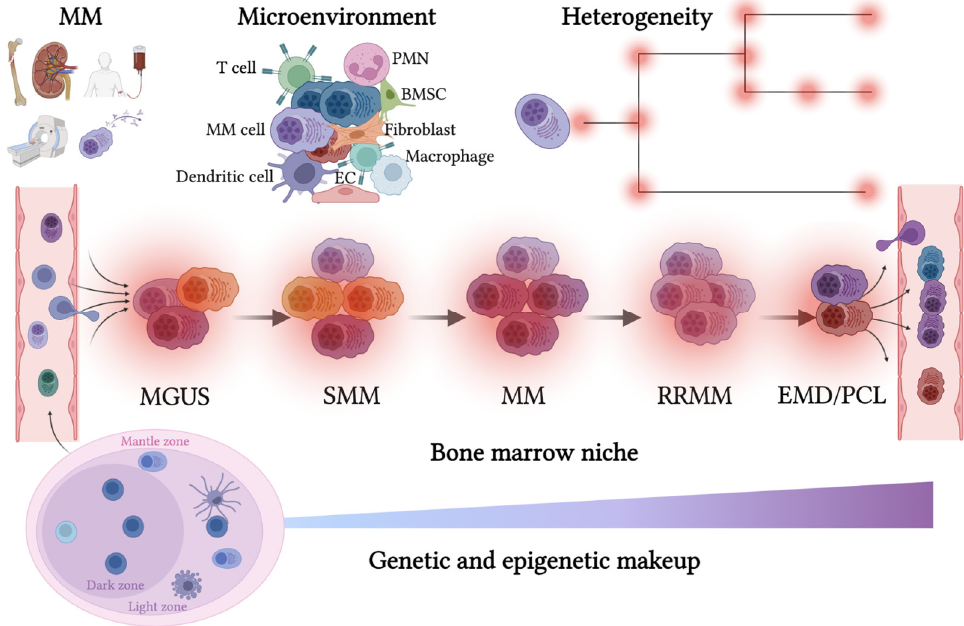
Figure 1. The route of the malignant plasma cell in its survival niche. Multiple myeloma disease trajectory is schematized. Upper panel, left, clinical C.R.A.B. (hypercalcemia, renal failure, anemia, and bone disease; additional diagnostic criteria S.Li.M. – sixty percent clonal bone marrow infil- tration, ratio light chains involved/uninvolved greater than 100, more than one focal lesion detected with MRI) results from cell-extrinsic and MM-intrinsic factors, driving disease progression. Left side, bottom: germinal center with B cells, plasma cells, and follicular dendritic cells; top: immune-microenvironment infiltration (left) and scheme of multiple alterations building heteroge- neous genomic architecture (right). MM: multiple myeloma; PMN: neutrophil granulocytes; BMSC: bone marrow stromal cell; EC: endothelial cell; MGUS: monoclonal gammopathy of undetermined significance; SMM: smoldering multiple myeloma; EMD: extramedullary disease; PCL: plasma cell leukemia. Created with BioRender.com.